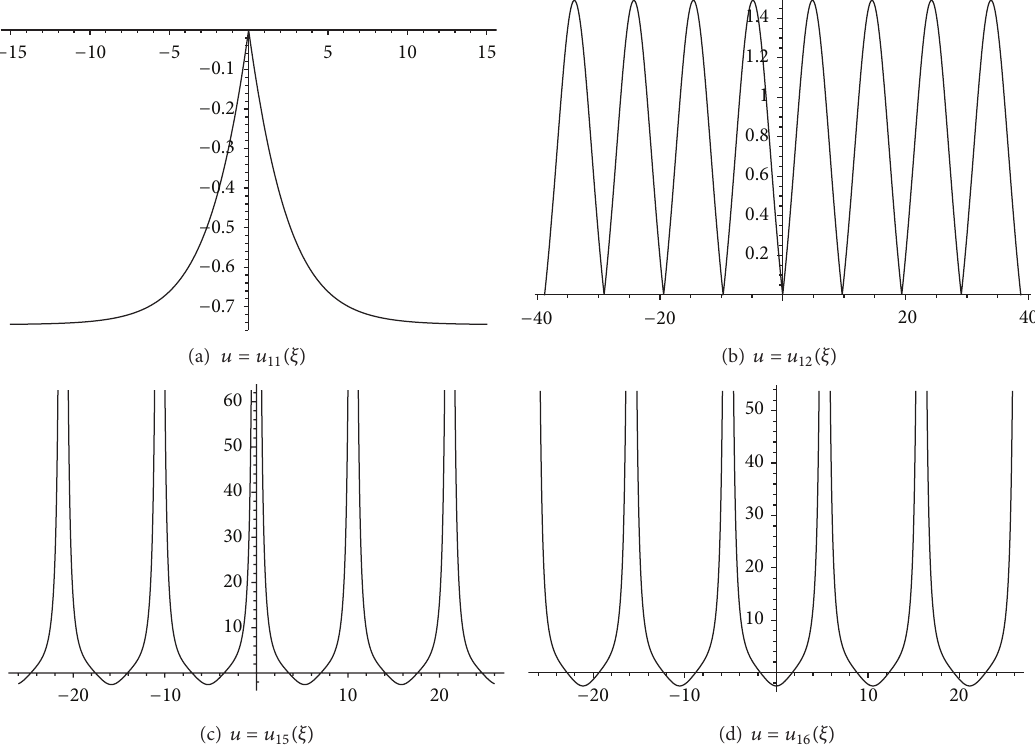
Figure 7: The graphs of 𝑢 11 (𝜉) , 𝑢 12 (𝜉) when 𝑐 = 2 , 𝑔 = 4√5/27 and 𝑢 15 (𝜉) , 𝑢 16 (𝜉) when 𝑐 = −1 , 𝑔 = −10 .